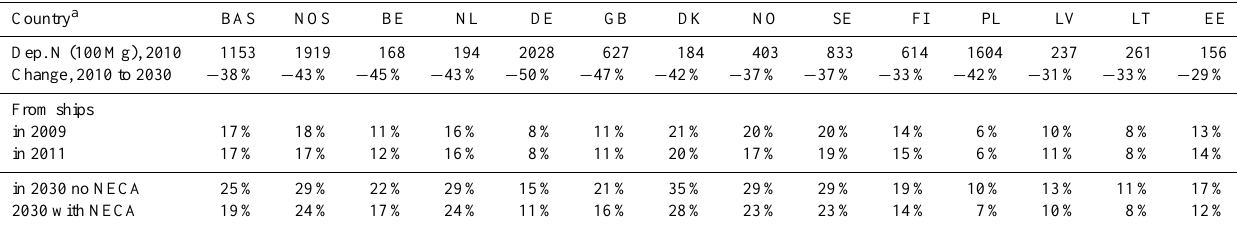
Table 3. Depositions of oxidized nitrogen with units 100Mg as N calculated with 2010 land-based emissions and ship emissions in the Baltic Sea and the North Sea for 2009. The change in depositions between 2010 (2009 ship emissions) and 2030 is given in percent. The percentage contributions from ships in 2009 and 2011 are calculated relative to the 2010 land-based emissions. The share from shipping in 2030 is listed both with and without a NECA implemented in the two sea areas. Country a BAS